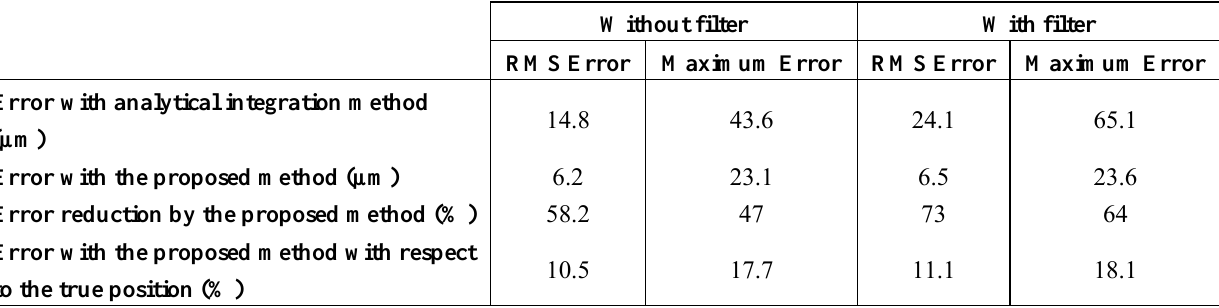
Table 1. Position estimation errors with the proposed method and the analytical integration method with and without the simulated hardware filter.